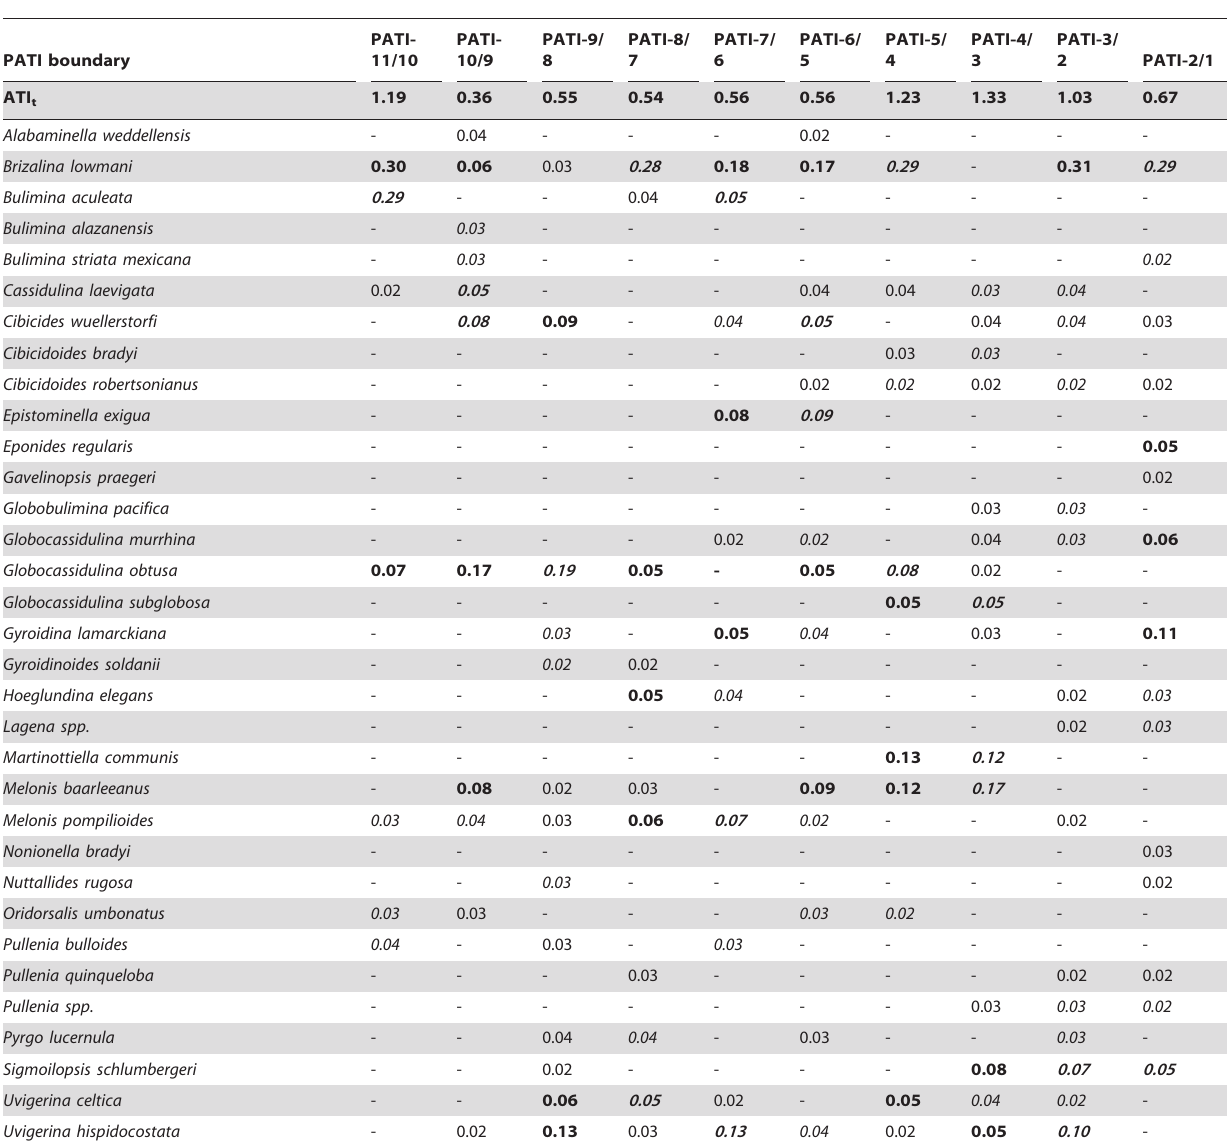
Dashes indicate CoBI t , 0.02, bold indicates CoBI t . 0.05. Italics indicate that a species’ proportional abundance decreased over a PATI boundary.